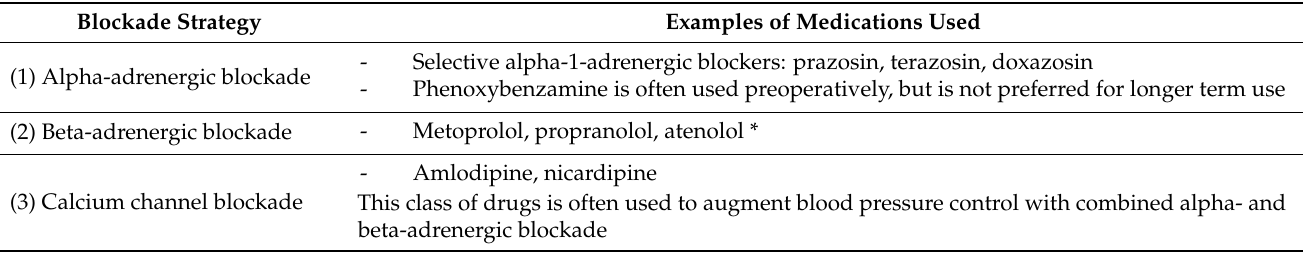
Table 2. Recommended approach of combined alpha- and beta-adrenergic blockade for PCCs and PGLs to maintain blood pressure at ≤ 120/80 mmHg and heart rate <100 bpm prior to initiating PRRT. Blockade Strategy Examples of Medications